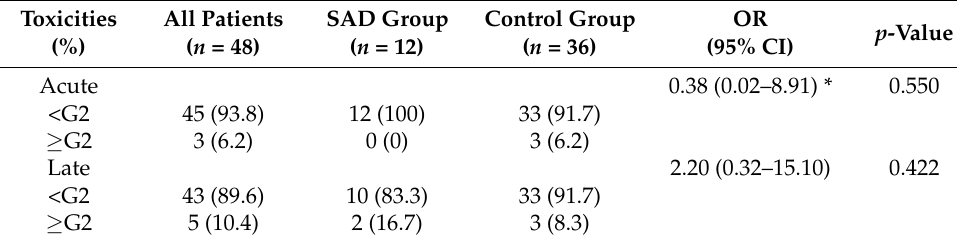
Table 4. Rates of acute and late RP ( ≥ G2) by the SAD and control